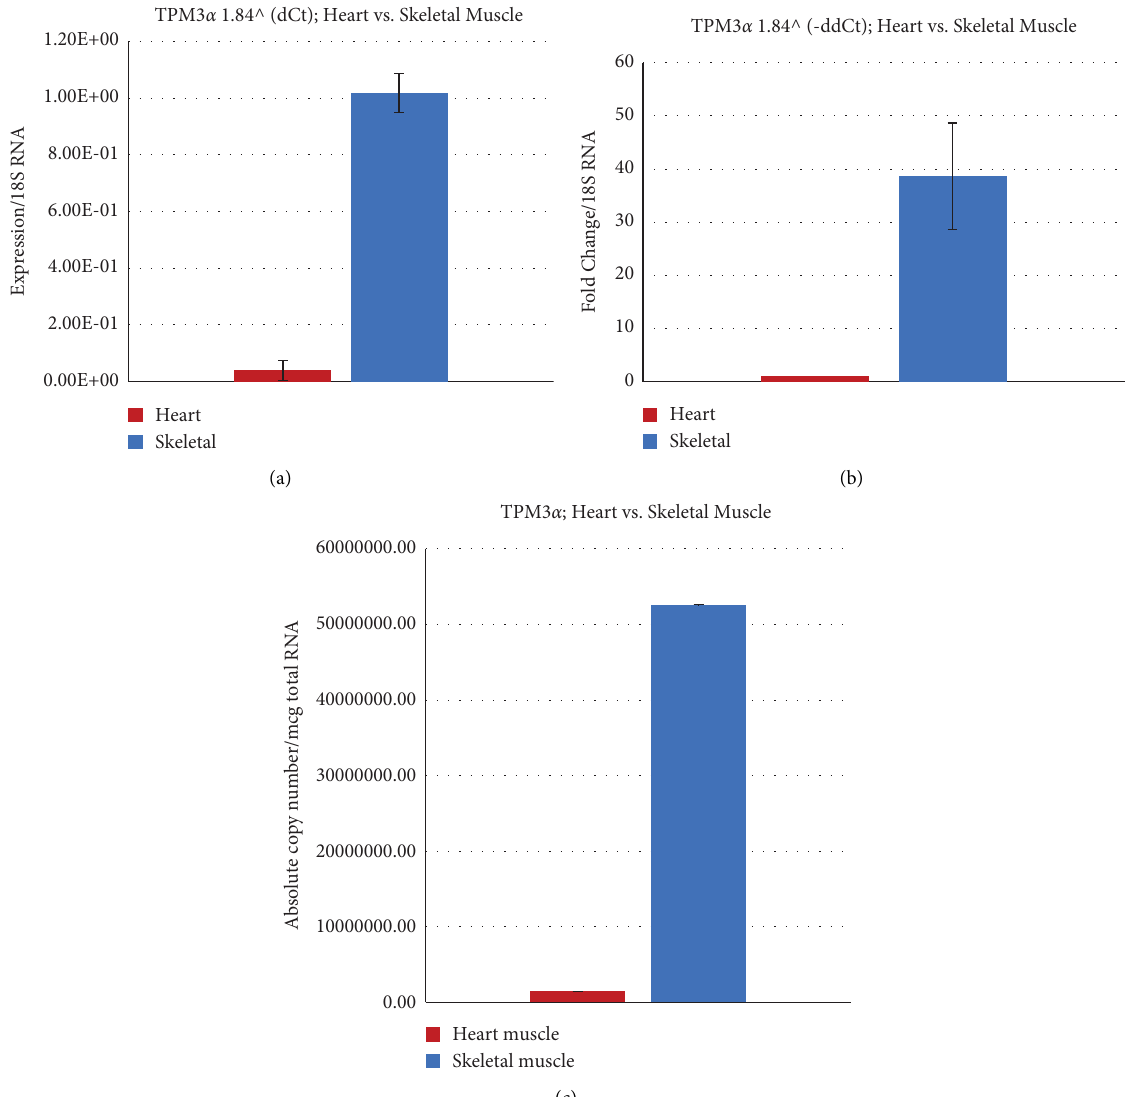
Figure 7: Relative and absolute expression of TPM3 α in the Cyn heart and skeletal muscle. (a) Relative expression of TPM3 α using the dCt method. (b) Fold change of TPM3 α using the ddCt method. (c) Estimation of the absolute copy number of TPM3 α in the Cyn heart and skeletal